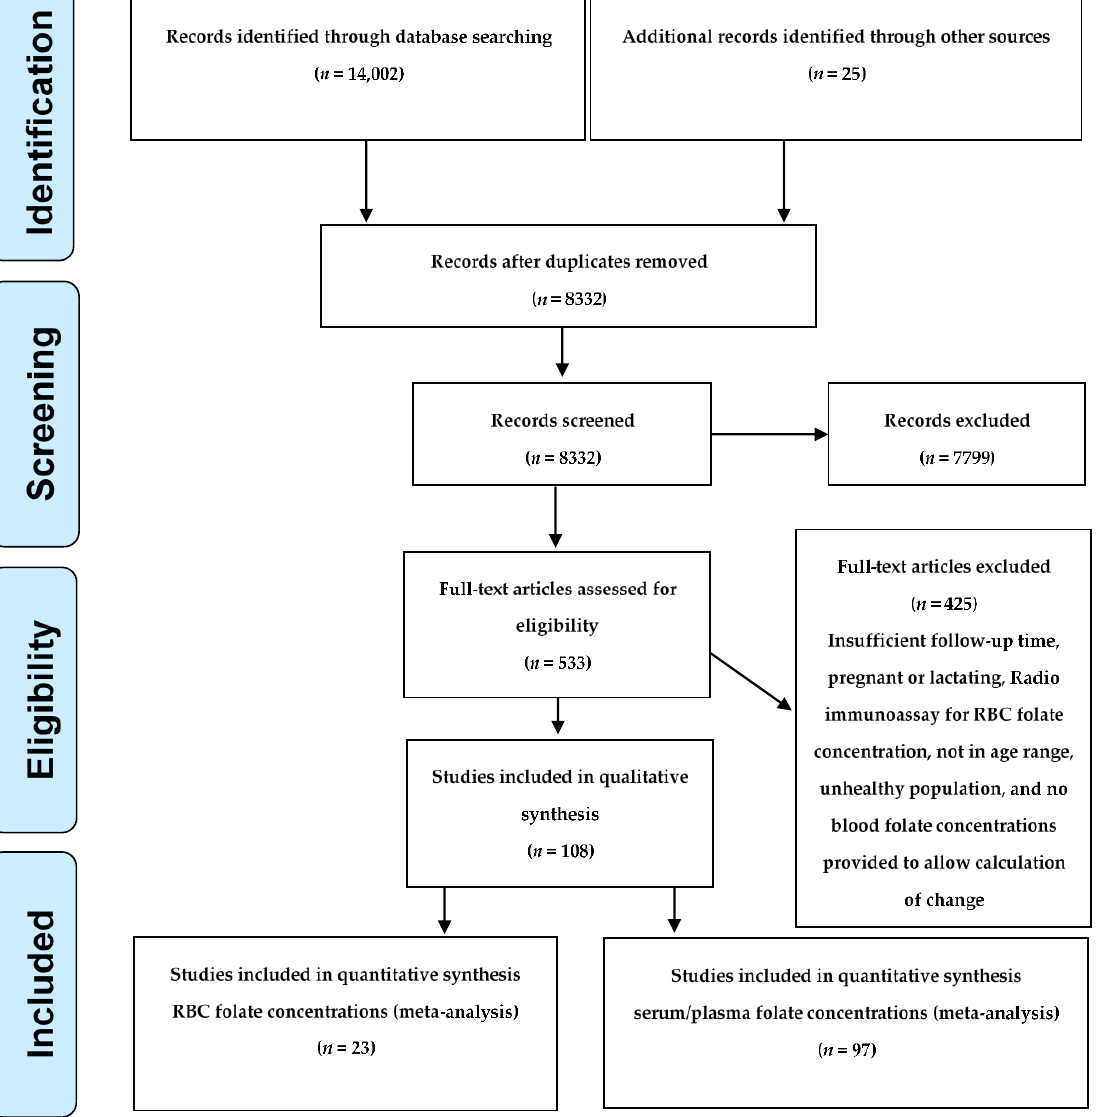
Figure 1. PRISMA Flow Diagram. RBC: red blood cell.